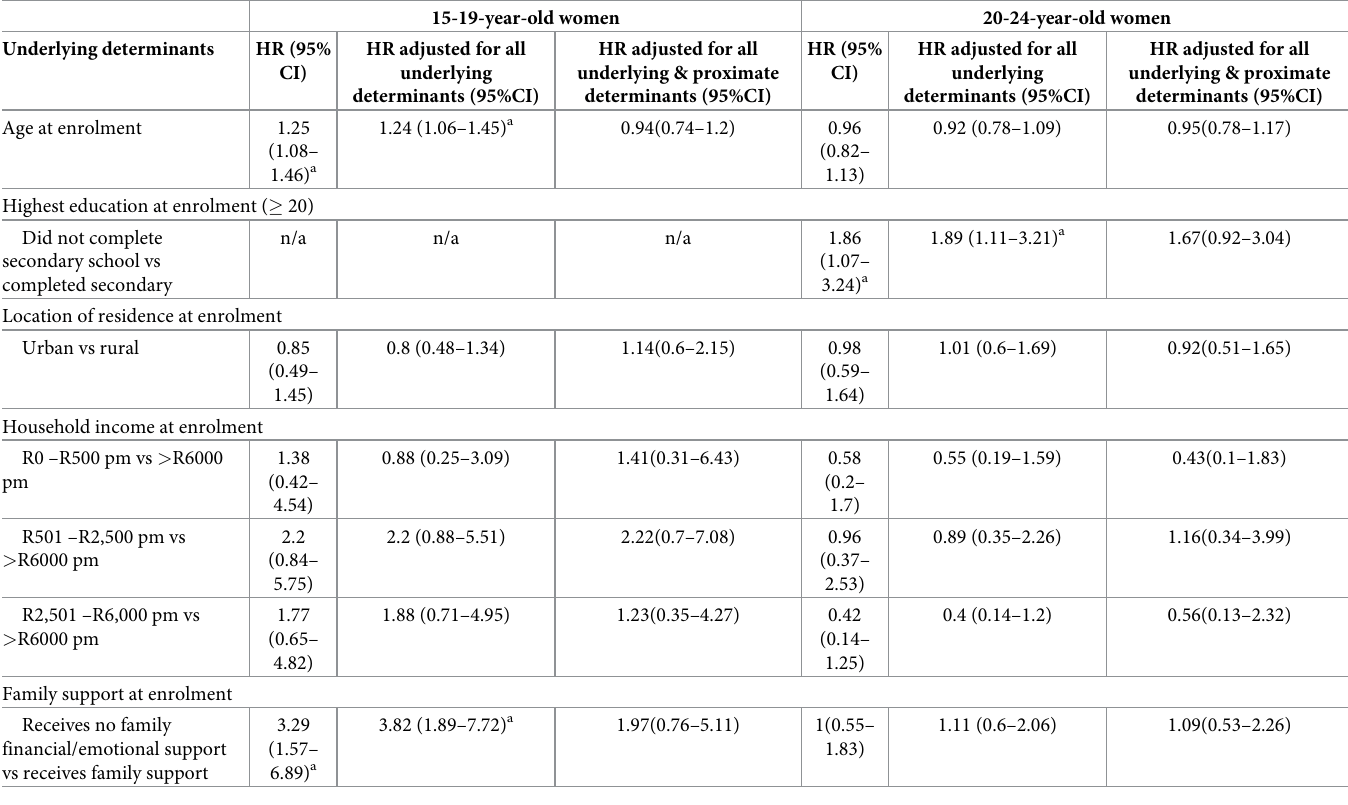
Table 3. Association between underlying determinants and HIV incidence in adolescent girls and young women enrolled in the HIPSS